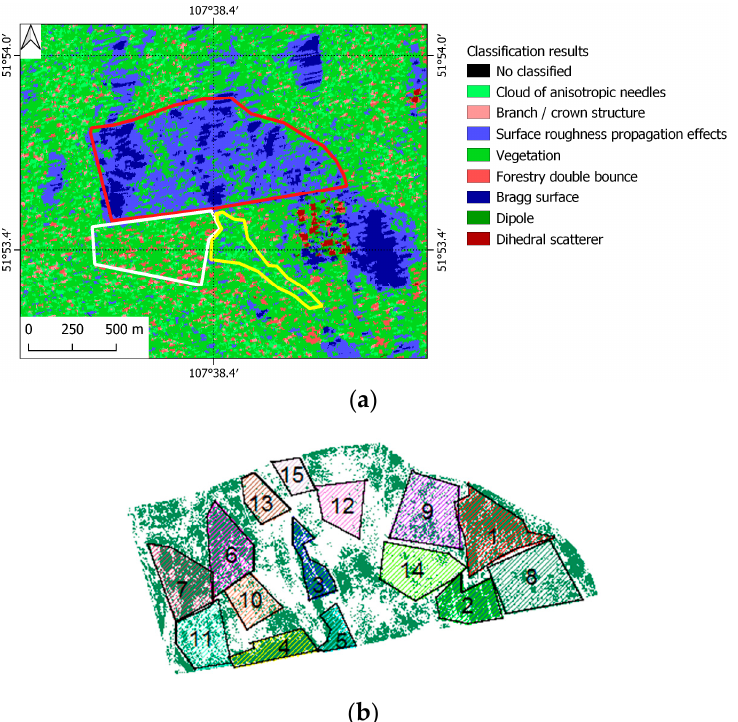
Figure 5. ( a ) H- α classification results according to 2019 data, and ( b ) 15 reforestation areas.